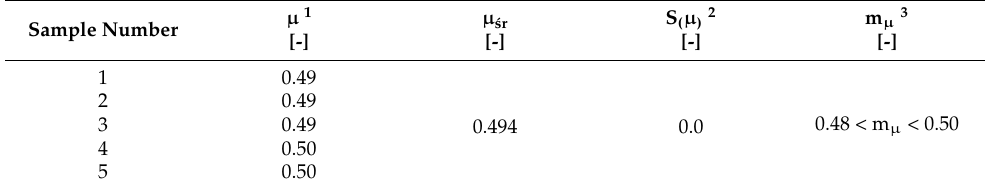
Table 4. Poisson’s number determination results µ for a population of 5